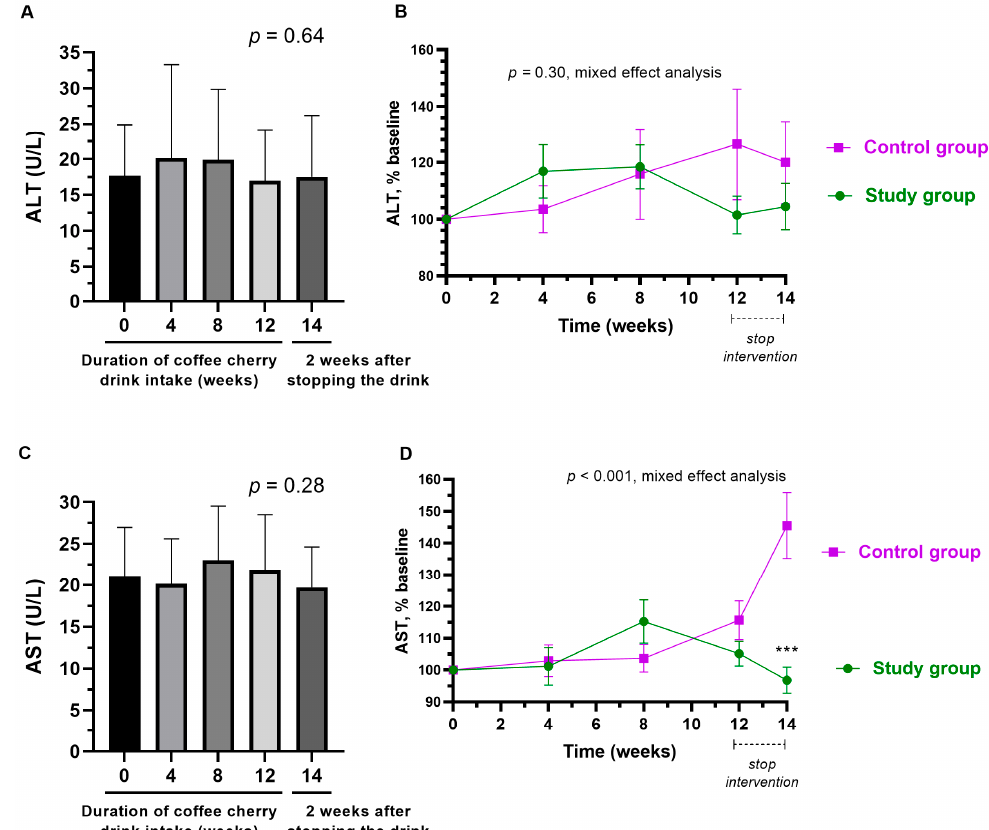
Figure 8. Changes in ALT and AST. The bar graphs show the mean and standard deviation of ALT( A ) and AST ( C ) after consumption of cherry coffee pulp juice concentrate for 4, 8, and 12 weeks, and 2 weeks after stopping the intervention (14 weeks), with p -value obtained from the Kruskal–Wallis test; the line graphs show a comparison of the mean and standard deviation of the ALT ( B ) and AST ( D ) in the percentage of the respective baseline values (% baseline) at each time point between study (green) and control (purple) groups, with p -value obtained from mixed-effect analysis. *** means p < 0.001.